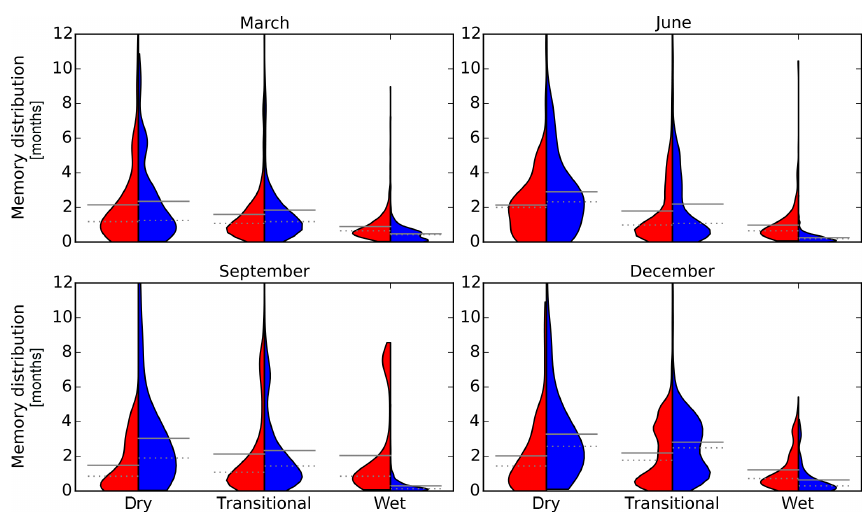
Figure 7. Violin plots of τ 0 distribution for dry (red) and wet (blue) initialization in the three soil moisture regimes for the four seasonal ensembles. The horizontal grey lines indicate the mean (solid) and the median (dashed) of the distributions. All land surface grid cells of a given regime are included.